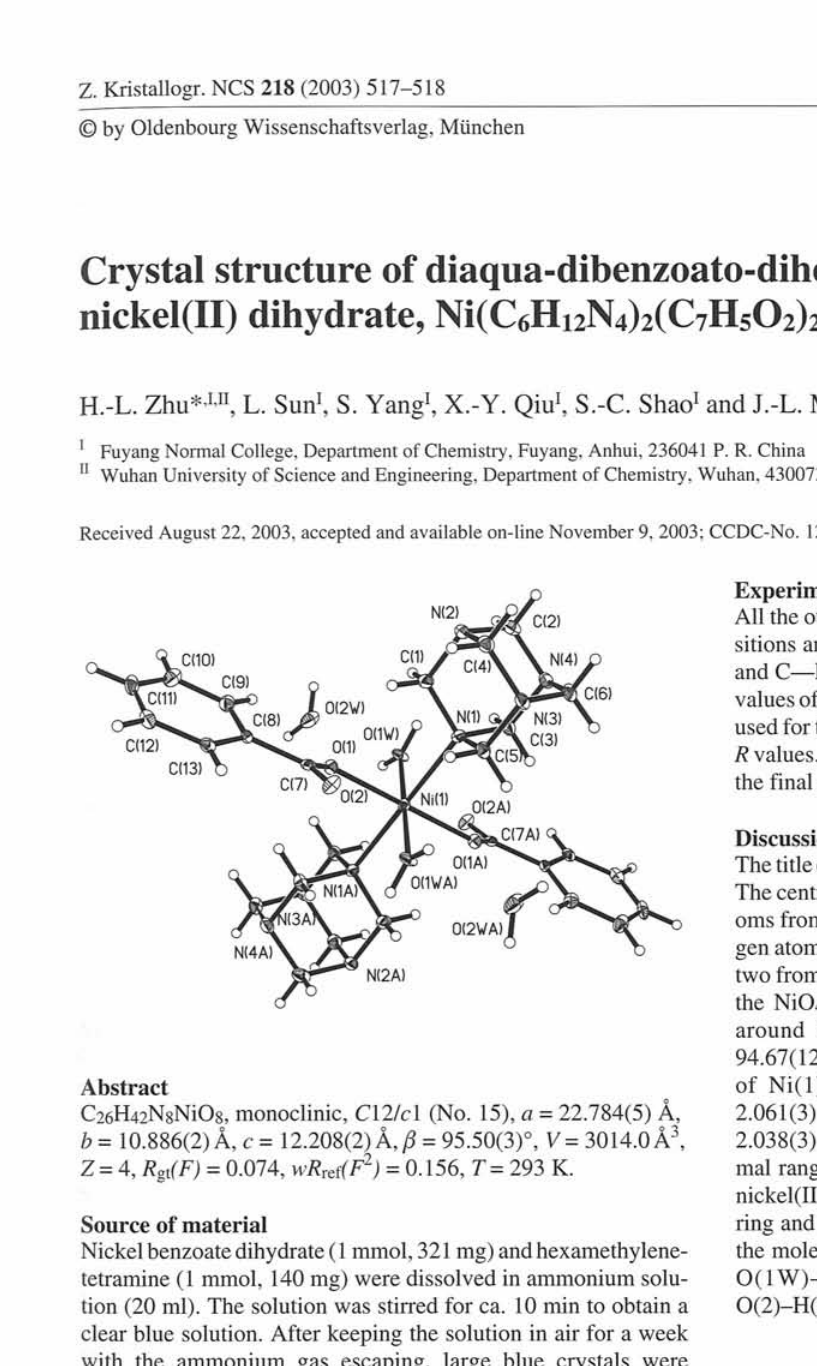
Table 1. Data collection and handling. Crystal: Wavelength: μ· Diffractometer, scan